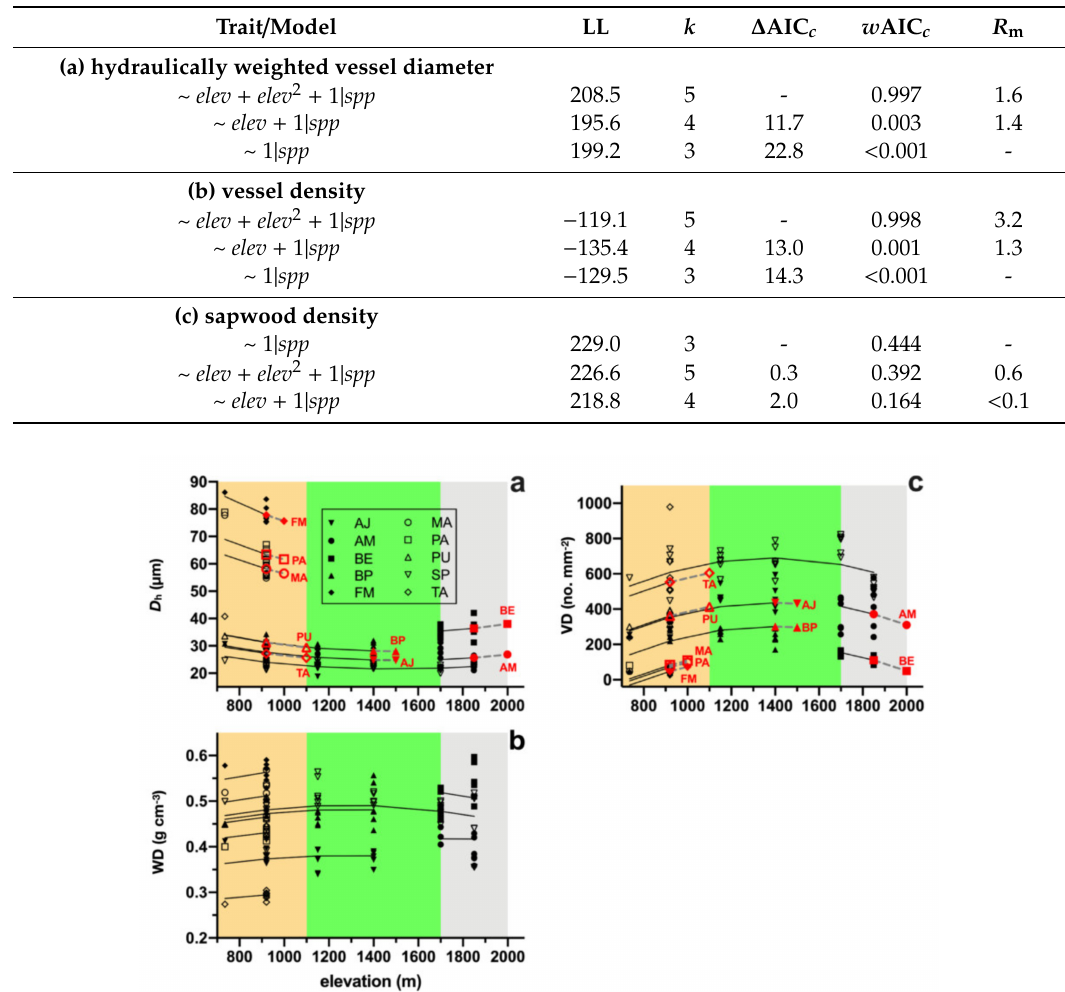
Figure 4. Change in functional traits relative to elevation for 10 species. ( a ) Hydraulically weighted vessel diameter ( D h , µ m) initially decreased with increasing elevation, then stabilized and rose again at higher elevations (however, the variance explained was low; see Table 2). ( b ) There was no evidence that stem sapwood density (WD, g cm − 3 ) changed with elevation. Predicted trait values at their putative upper elevational limits are shown in red (values provided in Table S2 and Figure 4). No prediction was made for sapwood density given the lack of evidence for an e ff ect of elevation. ( c ) There was evidence for a peak in vessel density (VD, mm 2 ) at mid-range latitudes. Also shown in each panel are the approximate elevational bands of the three main forest types sampled: MCDBL = mixed conifer-deciduous broadleaf (peach); CONIFER = conifer (green); DRB = dwarf rock birch